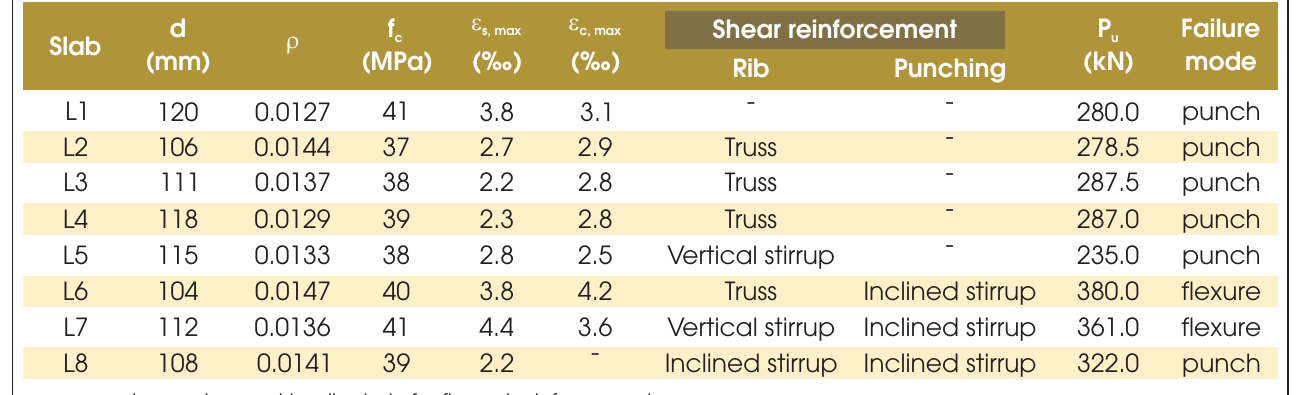
Table 4 – Slabs loads and modes of